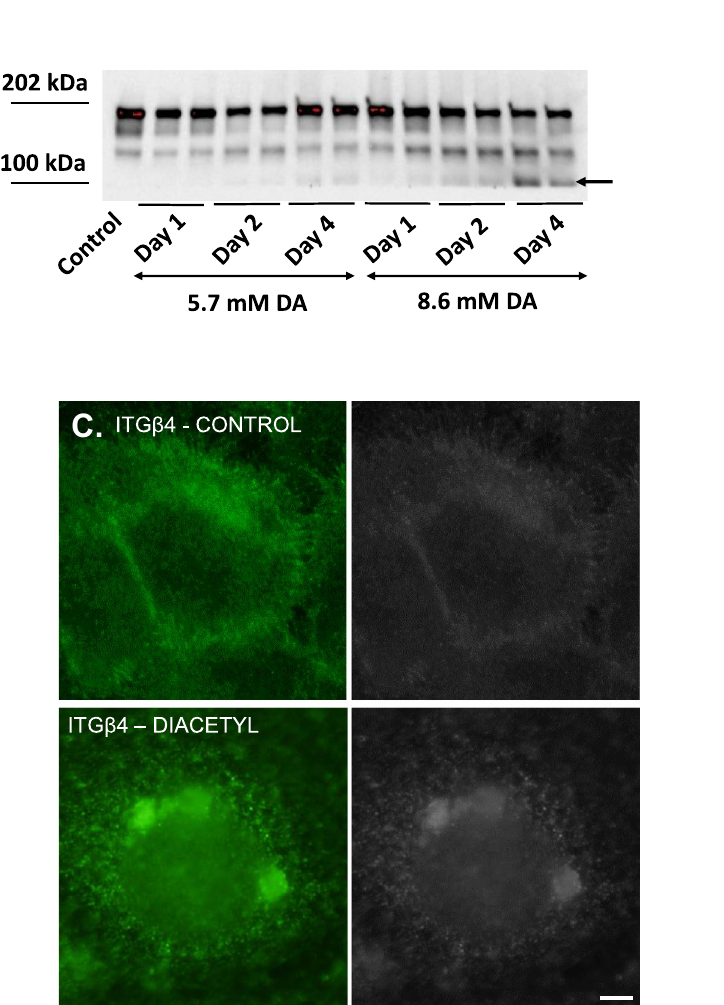
Figure 3. Modification to integrin beta 4 (ITGβ4) following DA exposure. ( A ) Representative western blot for integrin beta4 (ITGβ4) in epithelial cell homogenates in controls, Day 1, Day 2, and Day 4 after DA exposure. In cells exposed to 8.6 mM DA and cultured until Day 4, ITGβ4 expression at 202 kDa decreased with the appearance of ITGβ4 expression at approximately 100 kDa (far right two lanes, black arrows). ( B ) Semi- quantification of band density normalized for lane total protein. ITGβ4 abundance decreased significantly at Day 2 in both 5.7 mM and 8.6 mM DA at Day 2 (ANOVA, ****p < 0.0001 and ***p < 0.001, respectively). In 5.7 mM DA cultures, ITGβ4 abundance did not differ significantly compared to controls at Day 4 but remained significantly decreased relative to controls in 8.6 mM DA cultures (ANOVA, ****p < 0.0001). ( C ) Representative immunocytochemistry images of ITGβ4 in control cells (top) and cells exposed to 8.6 mM DA (bottom) (scale bar: 10 μm). Images obtained at Day 4 after DA exposure. In controls cells, ITGβ4 expression localizes primarily along the cell membrane. In DA-exposed cells, ITGβ4 expression localizes within the